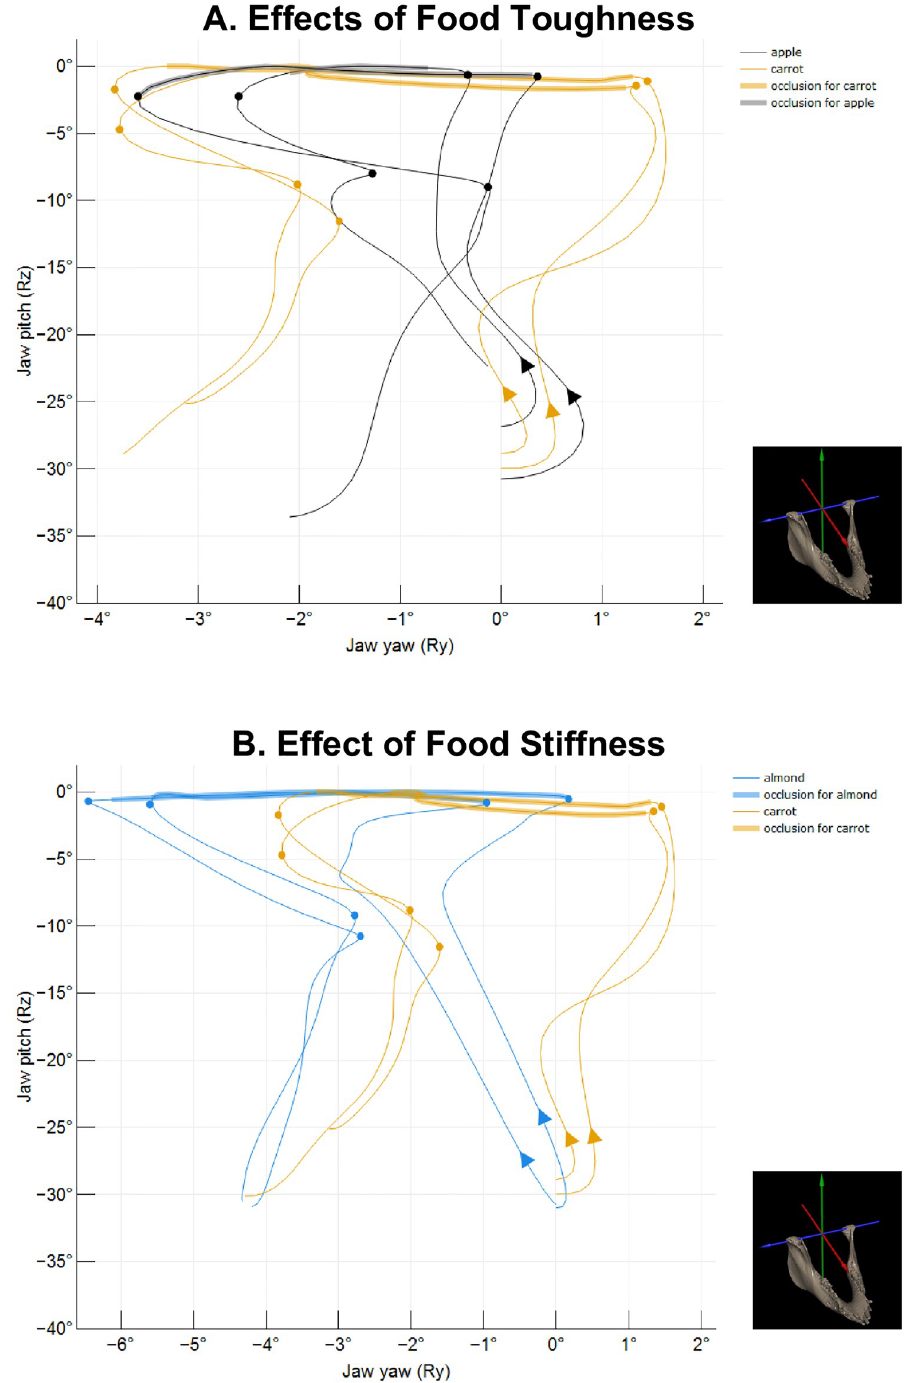
Fig 7. Representative chewing cycles for each food showing flexibility in pitch (Ry) versus yaw (Rz). Traces provide the trajectory of the jaw in frontal view for each food: ( A ) carrots (orange) vs apples (black) and ( B ) carrots (orange) vs almonds (blue). In A, note that the tougher food (carrot) elicits reduced Rz amplitudes during FC and an increase in Rz amplitude during SC. In B, note the overall similarity in the jaw movement profiles between carrot and almond, but that chewing stiffer food (almond) is associated with greater Ry. All traces were standardized to start at Ry = 0 and Rz was set at 0 at its minimum for that cycle. On each trace, the arrows indicate the start of each cycle, phase transitions are identified with a circle, and the occlusion phases are highlighted. Because pigs alternate chewing sides with each chew, right chews were mirrored to appear as left chews. Insets show the anatomical coordinate system used in the